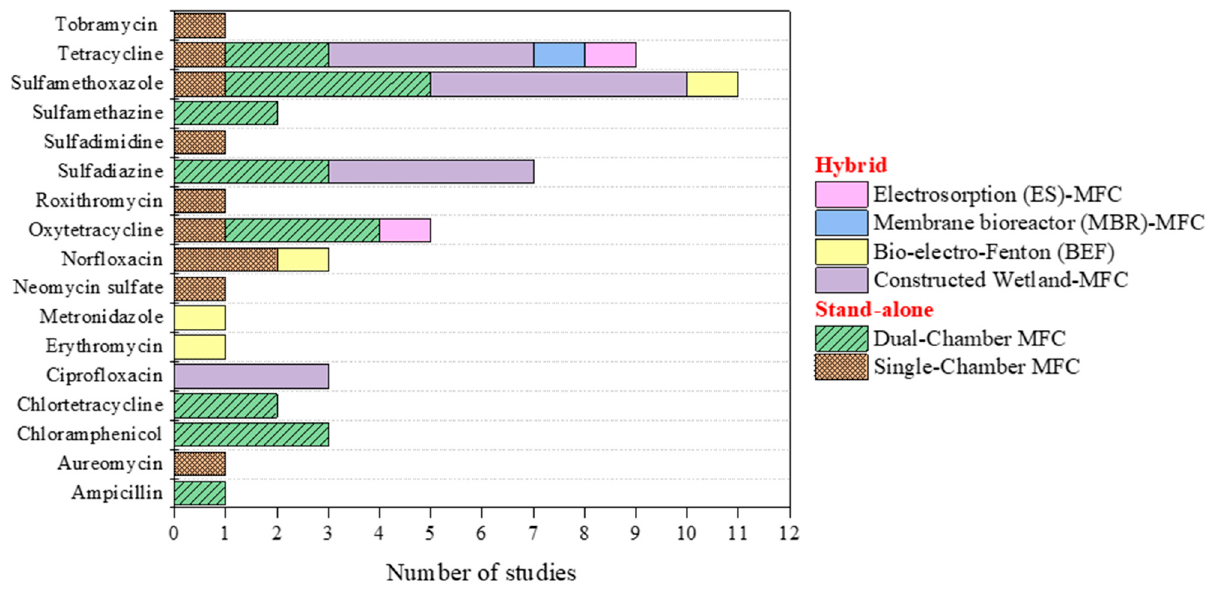
Figure 5. Different antibiotics studied in stand-alone and hybrid microbial electrochemical systems (based on the references shown in Tables 1–3).